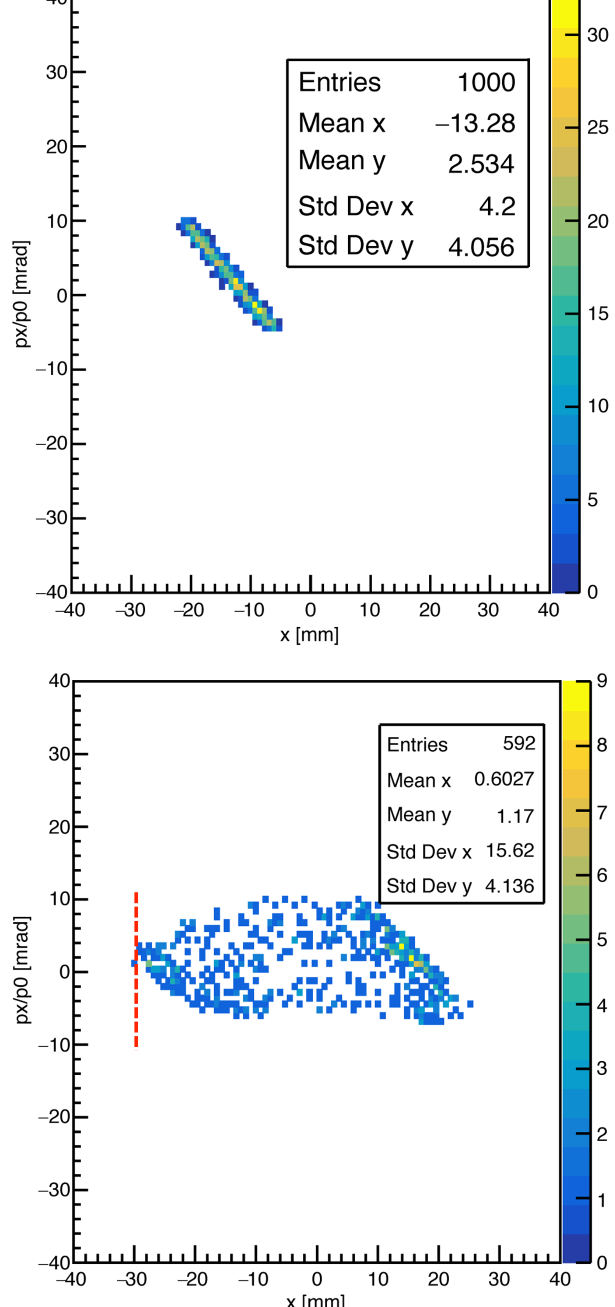
FIG. 6. H phase space of particles achieving − 20 mm of displacement, or more, at the extraction point plotted at the crystal. Top: turn 1. Bottom: turn 500. Particles migrate to negative horizontal offsets due to dispersion and energy loss up to go through the crystal (represented by the dashed red line in the